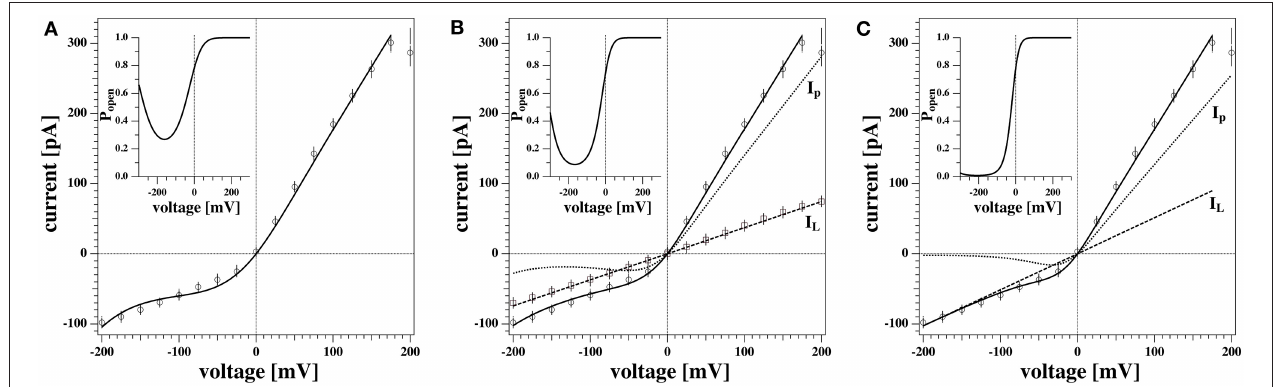
FIGURE 6 | Three different scenarios to fit the non-linear current-voltage relations. (A) Conductions by pores only ( g L = 0). (B) Conduction by voltage-dependent pores and a voltage-independent fixed leak current taken from the experiment in Figure 5C . (C) Same as (B) but the leak current was not fixed. The latter fit describes the data best. The inserts show the pore open probability for the three different scenarios. The minimum of P open represents the offset voltage − V 0 . See text for details.